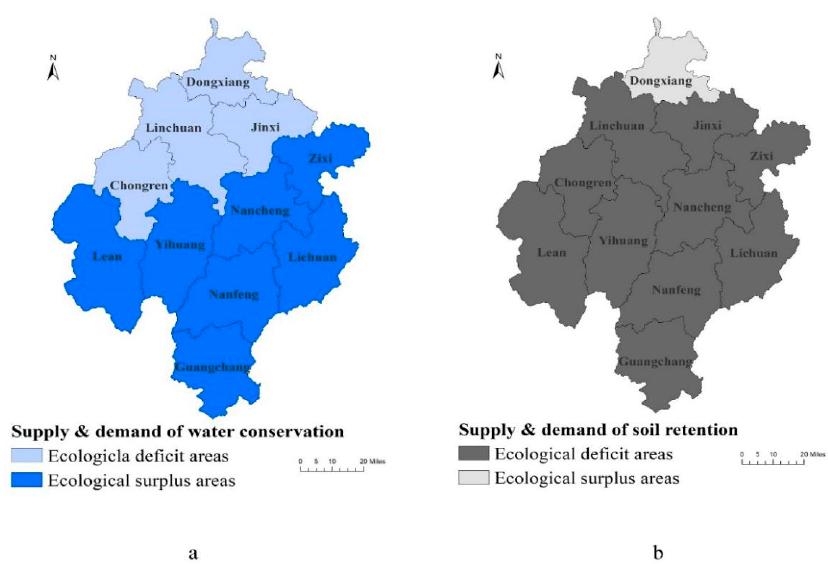
Figure 2. Supply and demand for water conservation and soil retention. ( a ) Districts or counties can be classified into ecological deficit areas and ecological surplus areas by calculating the difference between supply and demand for water conservation. Dongxiang, Linchuan, Jinxi, and Chongren belong to ecological deficit areas in water conservation. ( b ) Dongxiang is the sole ecological surplus area in soil retention.